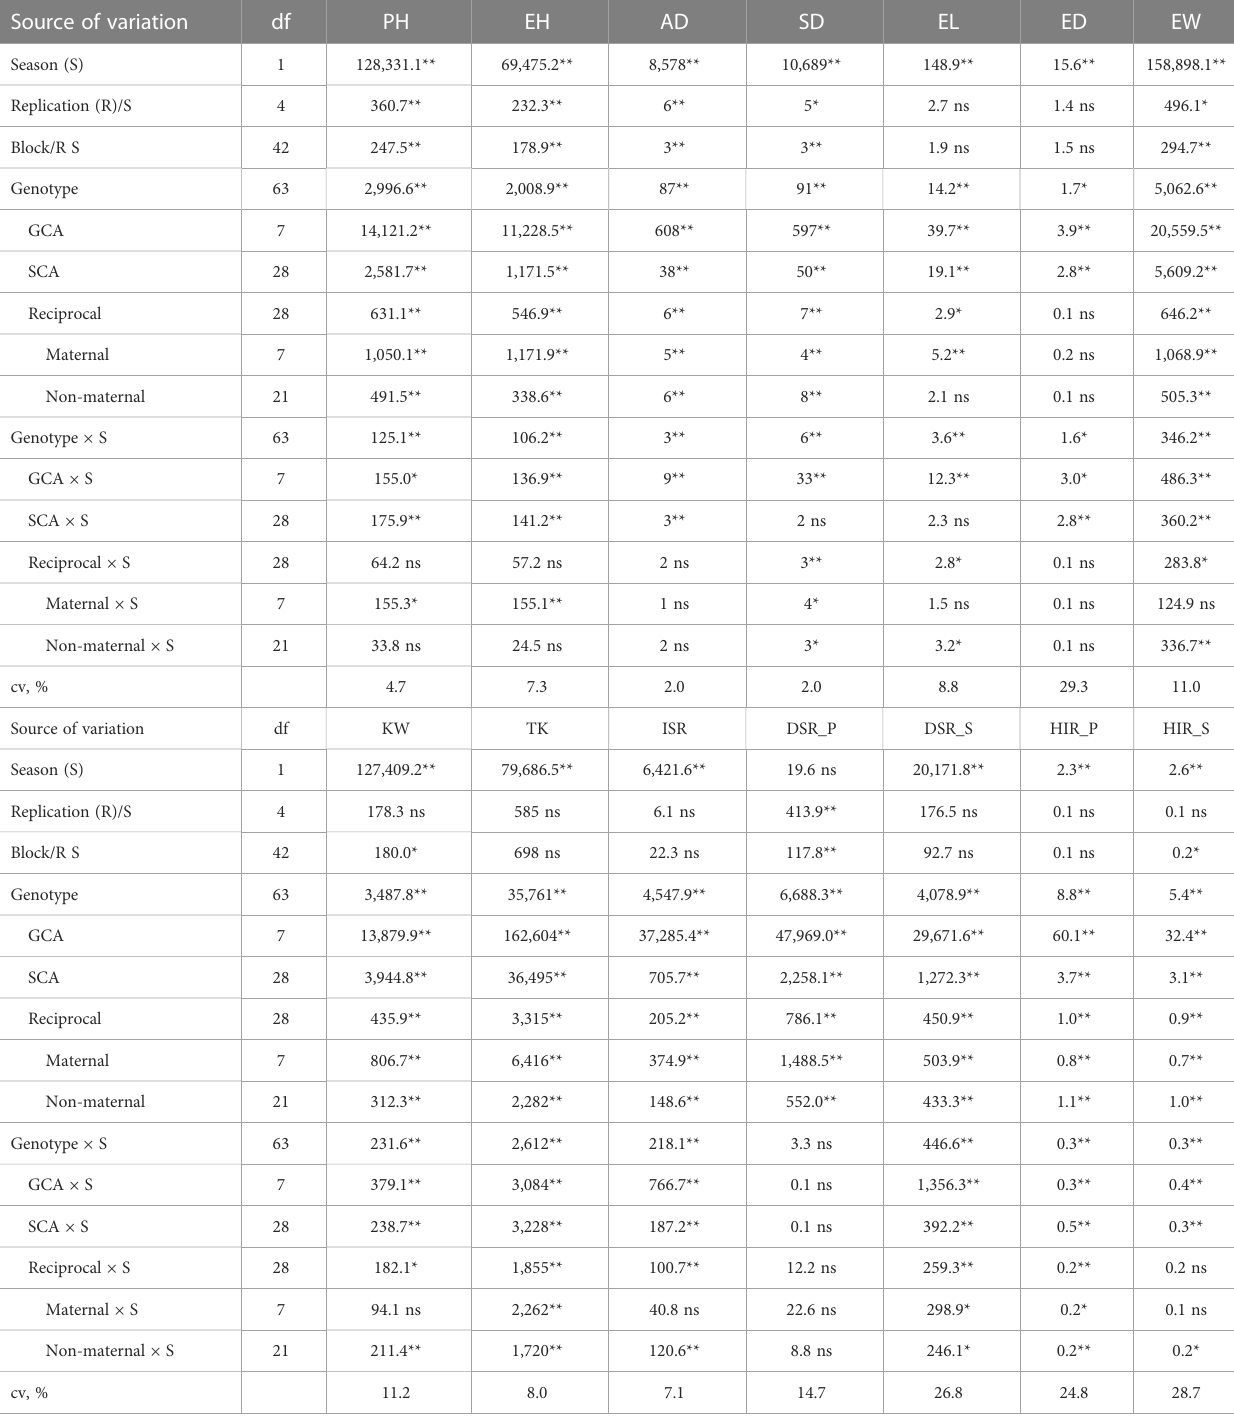
TABLE 2 Diallel analysis for agronomic traits, R1-nj seed set, and haploid induction rate of 8 parental genotypes and 56 F 1 progenies evaluated in the rainy season of 2021 and the dry season of 2021/2022. Source of